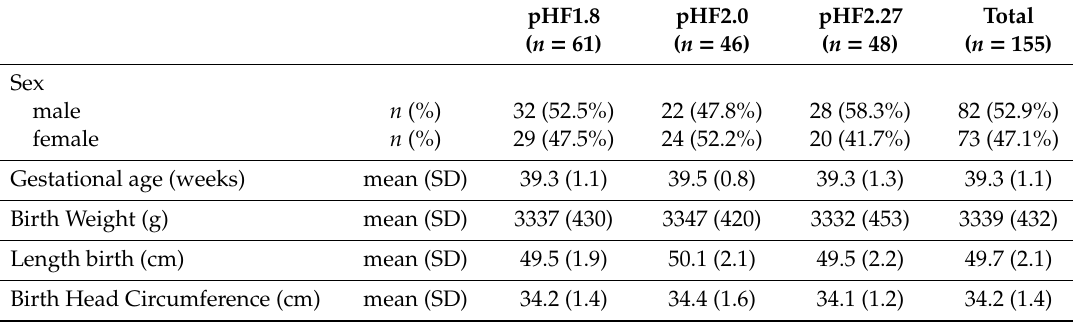
Table 1. Infant characteristics at birth of the Per Protocol (PP)